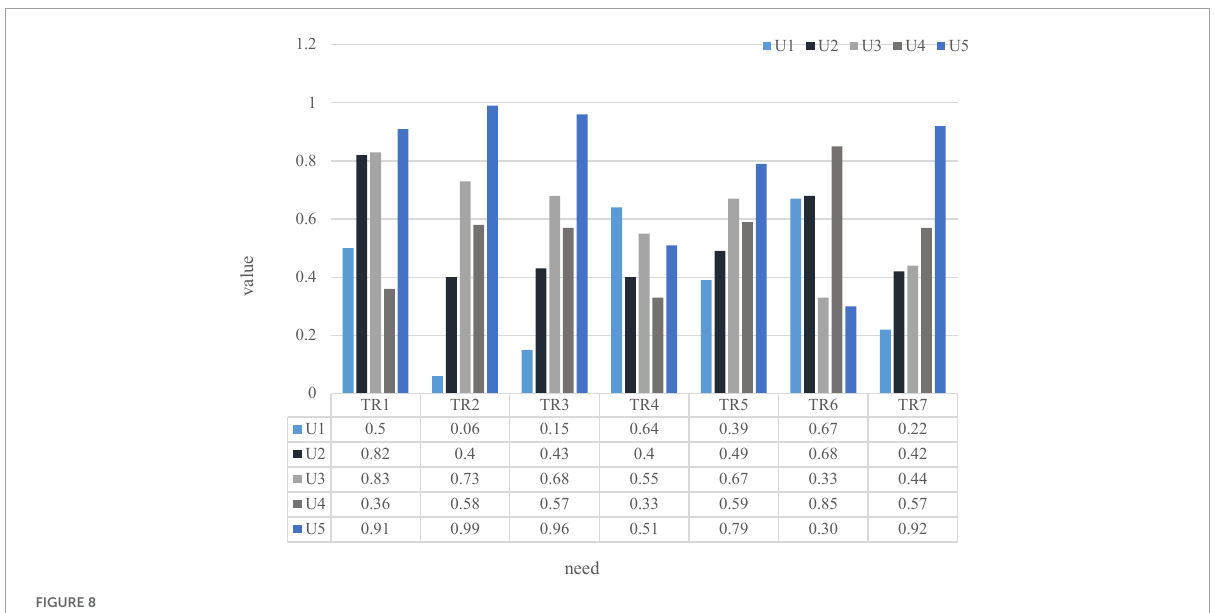
FIGURE8 Tourist demand value of tourist